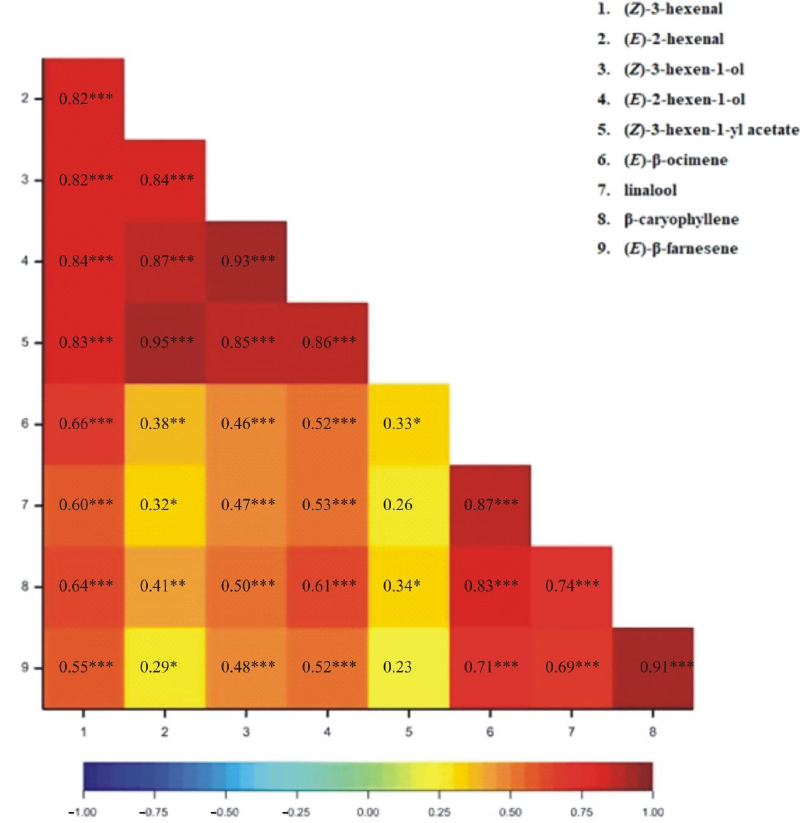
Figure 1. Heatmap for Pearson’s correlation coefficients between observed VOCs resulting from 1SL treatment (* p < 0.05; ** p < 0.01; *** p < 0.001).